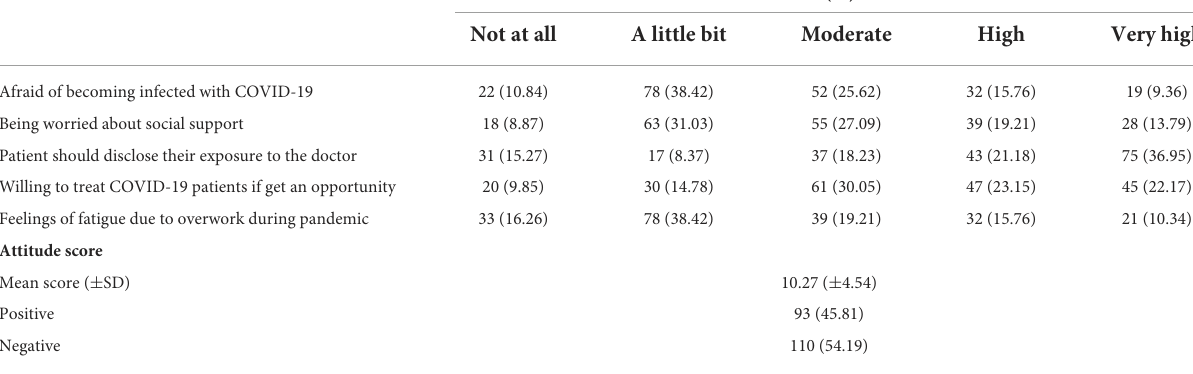
TABLE 3 Attitude assessment of healthcare professionals during COVID-19.